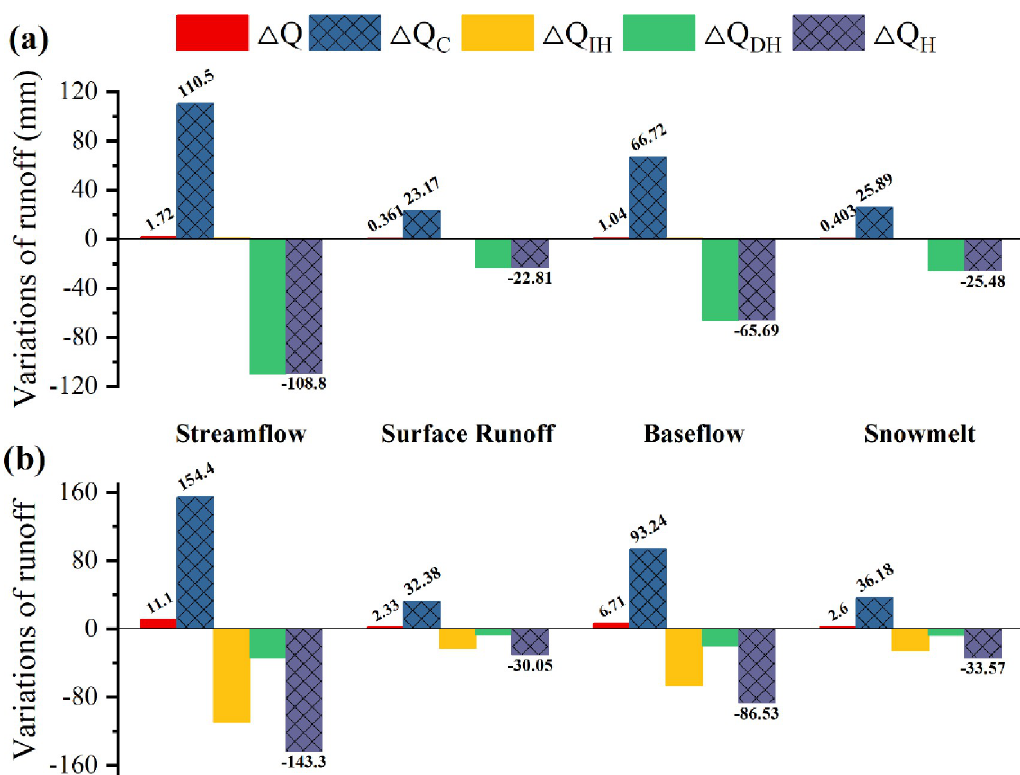
Fig 12. Effects of climatic and human factors on increasing trends in streamflow, surface runoff, baseflow, and snowmelt in the ELB during different impact periods, where (a) denotes impact phase I and (b) shows impact phase II.